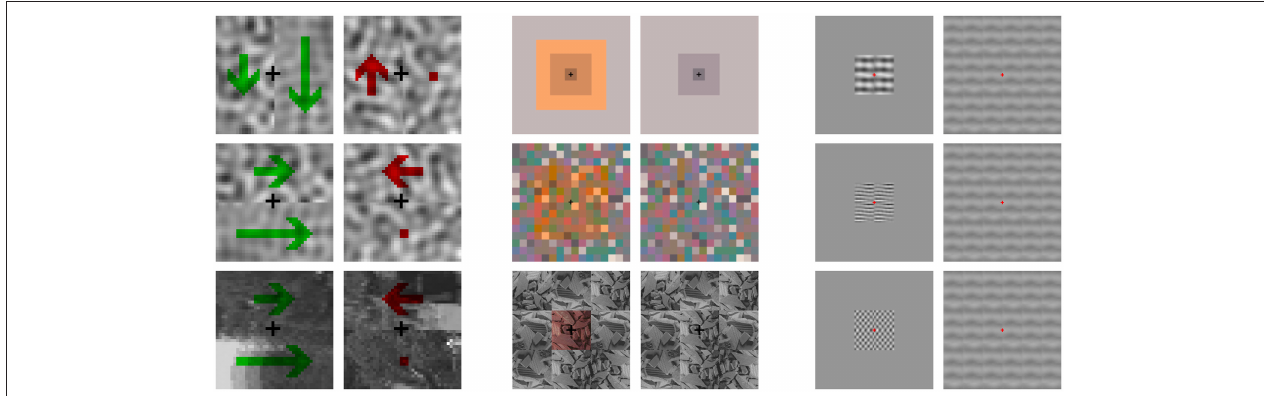
FIGURE 1 | Illustration of motion, color, and texture aftereffects. The three panels show adapting stimuli on the left, and the test stimuli to be presented after adaptation are on the right. Visit http://isp.uv.es/after_effects/ for animated presentations of tests after the corresponding adaptors. The code to modify the parameters of these renderings is also available therein. Left (Motion) the first waterfall effect example (top) consists of a random noise sequence with different up-down speeds (represented by the green arrows) around the fixation point. When the sequence physically stops, the left part seems to move in the opposite direction while the right part is perceived as static (as represented by the red arrows). This effect works in any orientation (not only up-down) and also for natural images (second and third examples). Center (Color) color and contours of the scenes on the right of the panel change after adaptation to the scenes on the left: an illusory cyanish patch emerges around the fixation point in the physically stationary test due to the adaptation to the yellowish center of the previous stimulus. Right (Texture) while the contrast of the textures in the right column is stationary, it is perceived in different ways after adaptation to the high contrast achromatic textures on the left. Note that the strength of the induced blindness depends on the correspondence between frequency and orientation of the previous and post scenes.